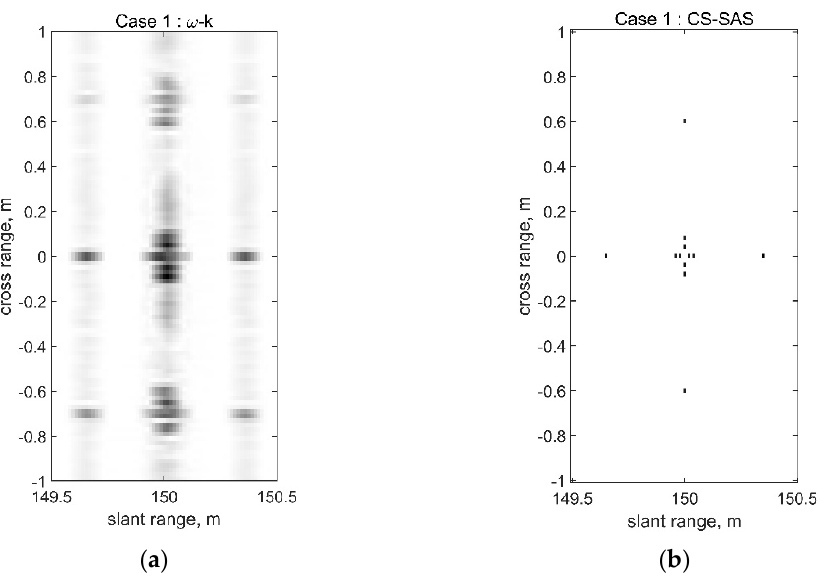
Figure 11. Simulation results for Case 1 for uniform line array: ( a ) result for the ω -k algorithm; ( b ) result for the CS-SAS algorithm for uniform line array.